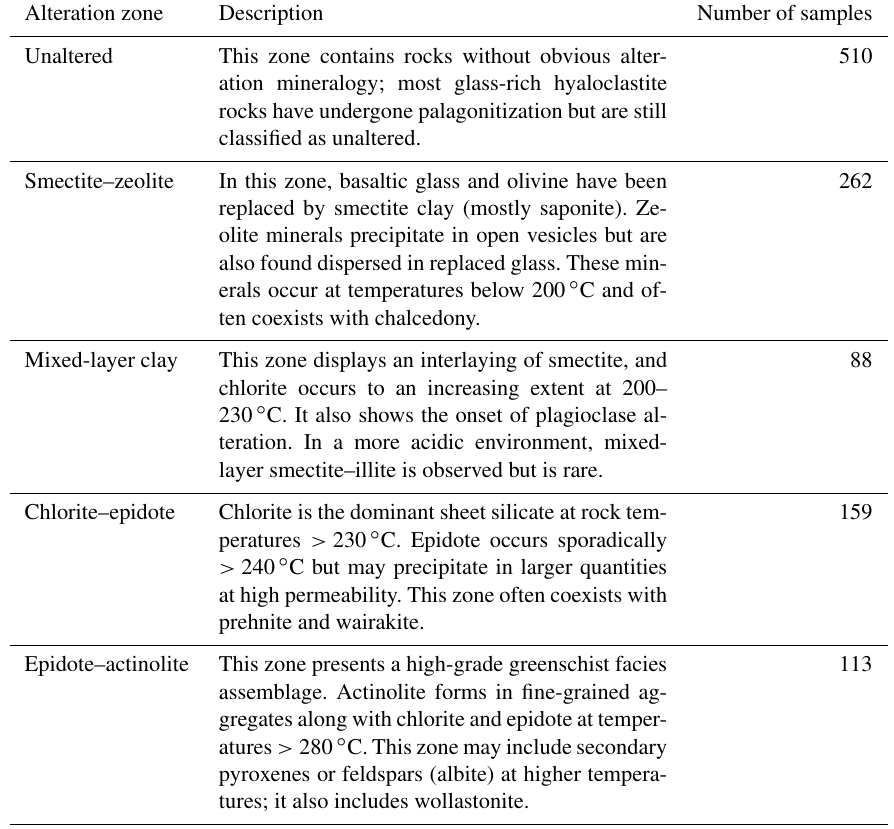
Table 3. Description of the alteration zones and the number of samples in the database corresponding to each alteration zone.